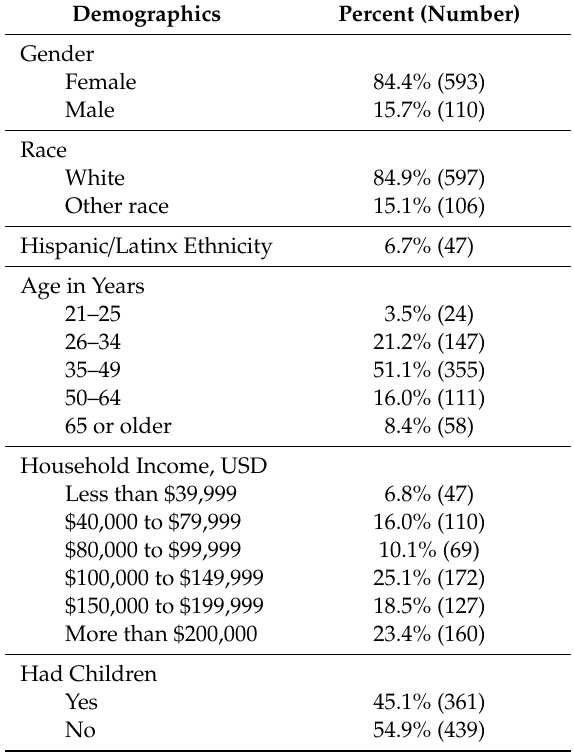
Table 1. Demographics from Alcohol Use & COVID-19 Survey, 2020 ( n =